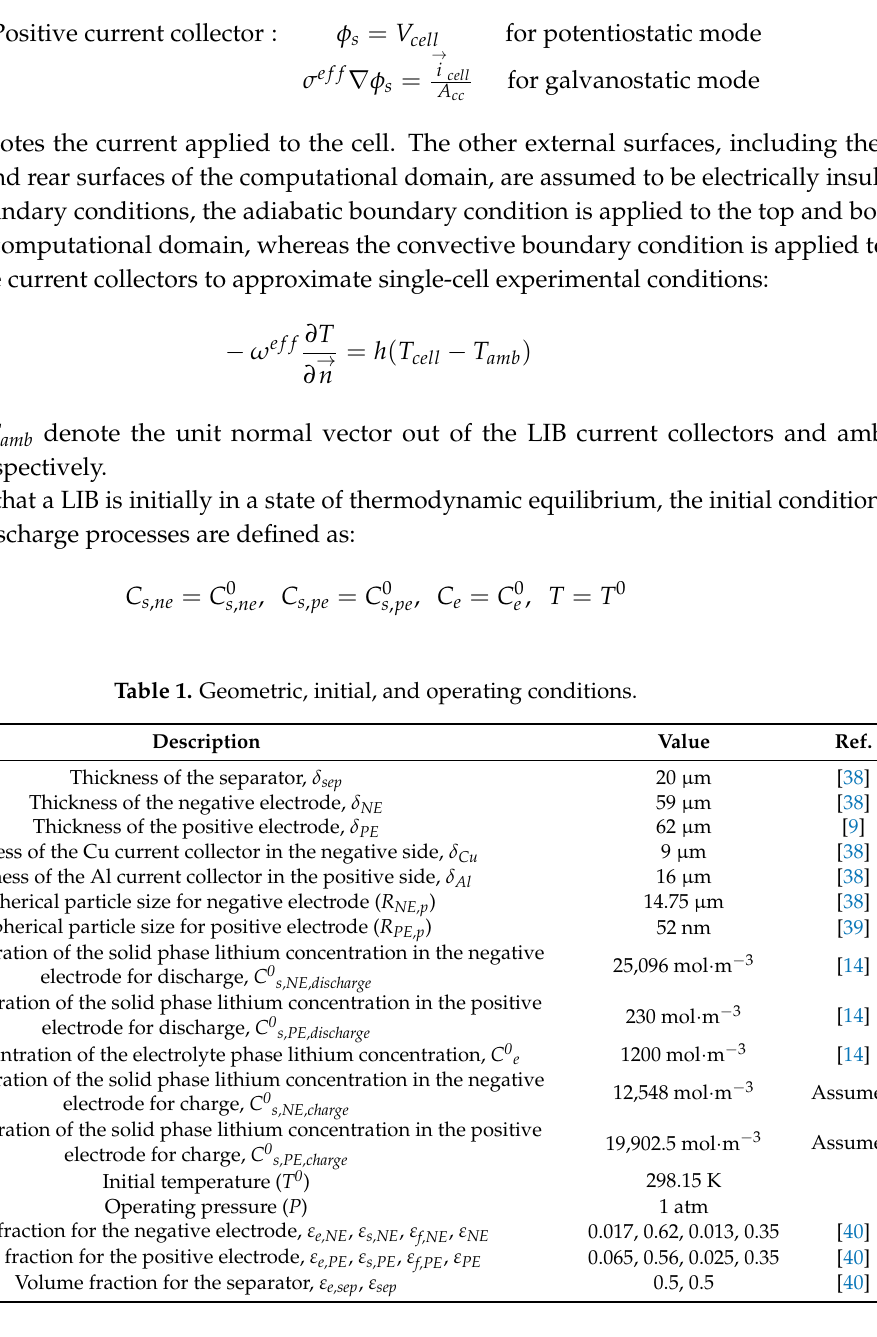
Table 2. Kinetics, physiochemical, and transport